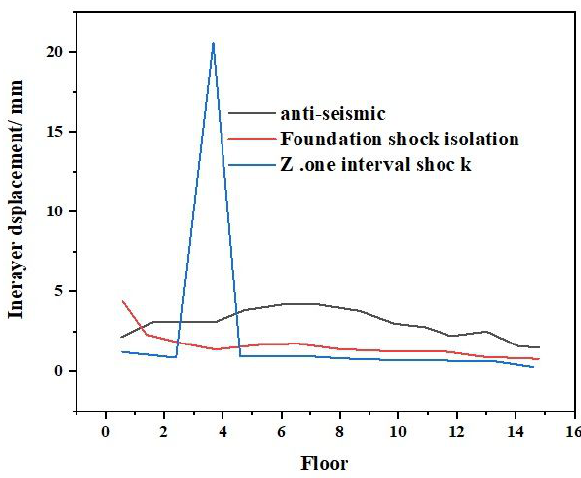
Figure 3: Interlayer displacement of Taft wave under multiple earth-